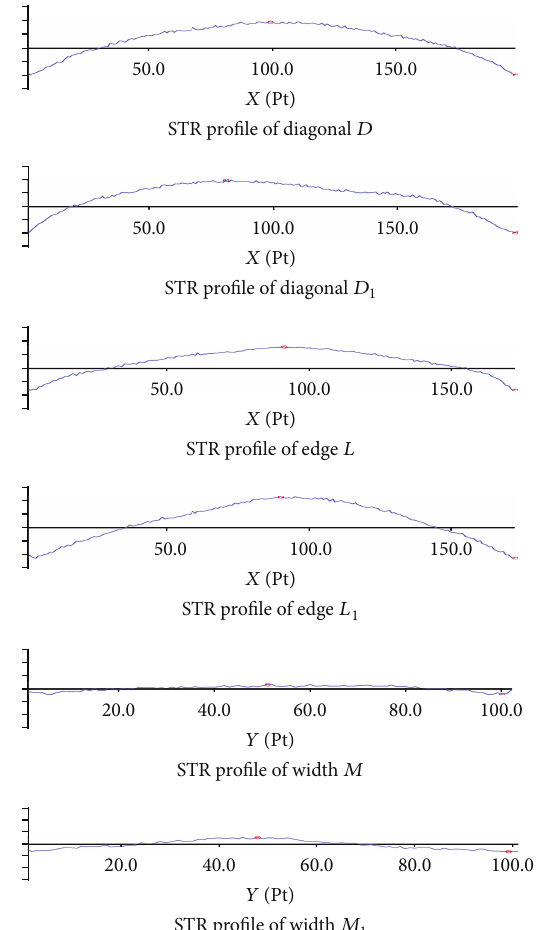
Figure 4: Result of STR form for 𝐷 and 𝐷 1 , 𝐿 and 𝐿 1 , 𝑀 and 𝑀 1 lines of second specimen in the new method.